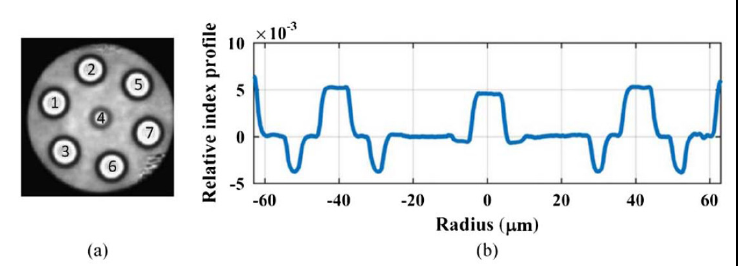
Figure 4. ( a ) Cross-sectional view of the MCF used in the experiment. ( b ) Relative index profile of the MCF. (Reprinted/Adapted) with permission from [38] © The Optical Society.